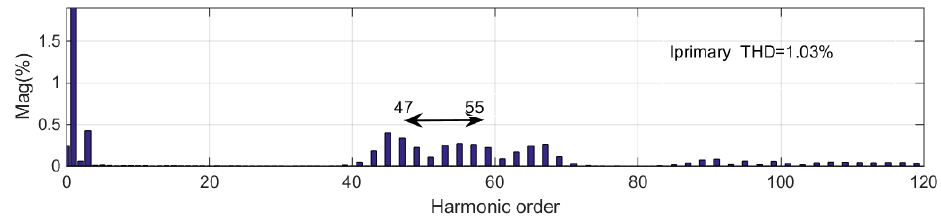
Figure 15. Fourier analysis of transformer primary current.